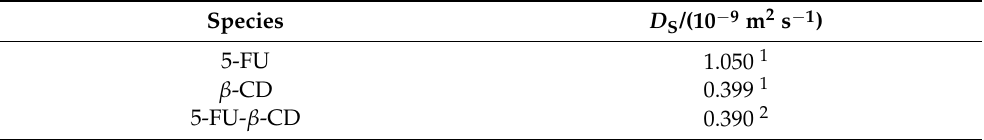
Table 3. Limiting diffusion coefficients, D s , of species present in the system 5-FU + β -CD at T = 298.15